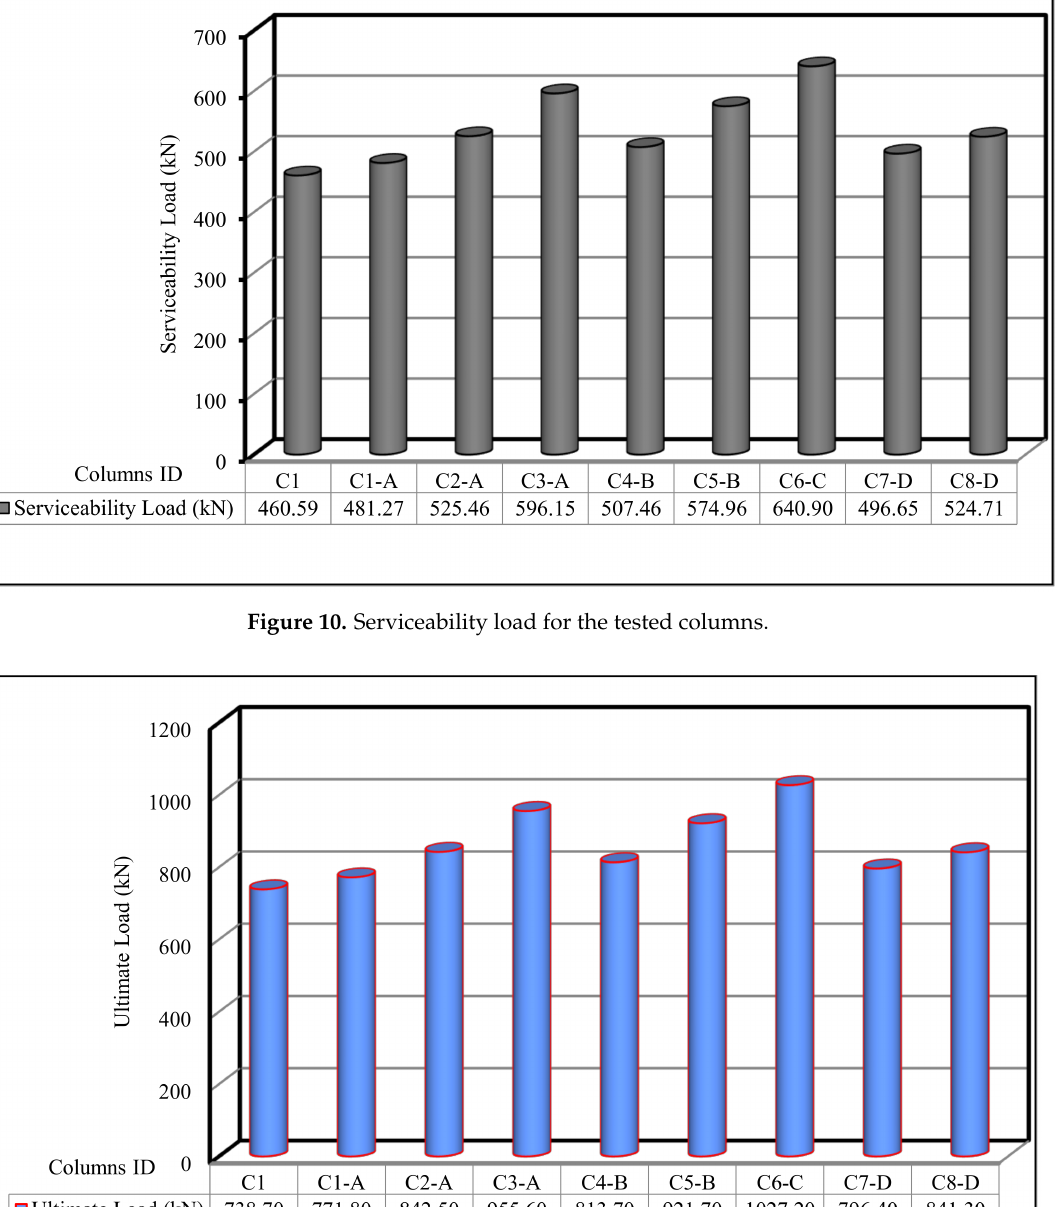
Figure 11. Ultimate load for the tested